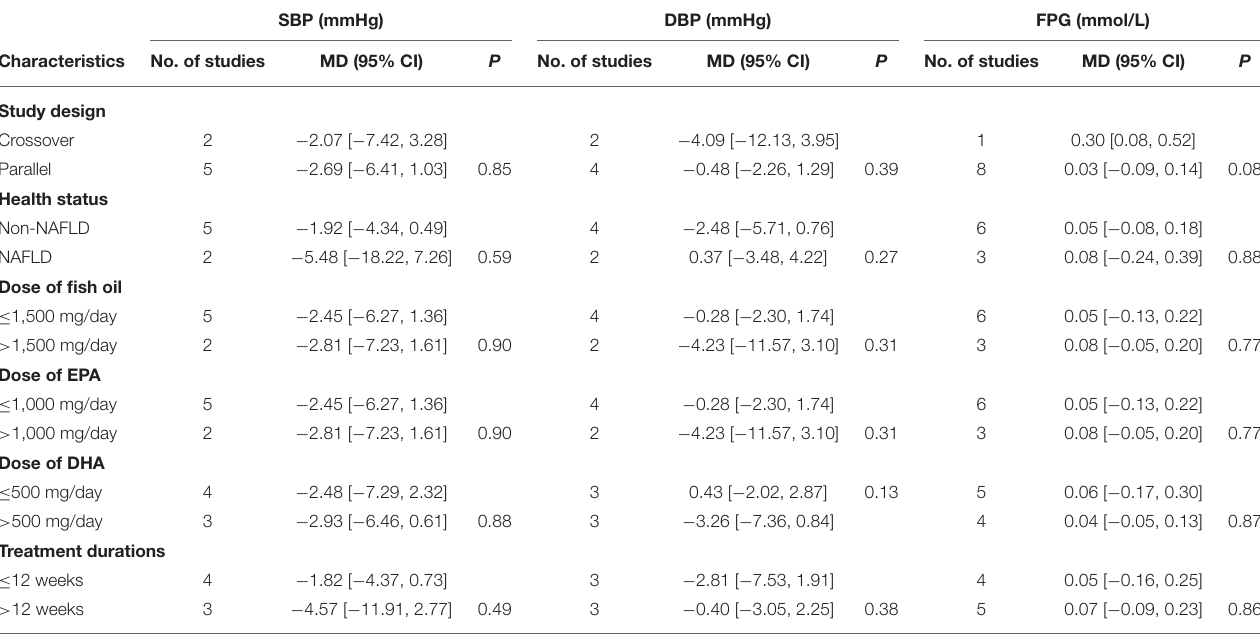
TABLE 6 | Subgroup analyses for the outcomes of blood pressure and